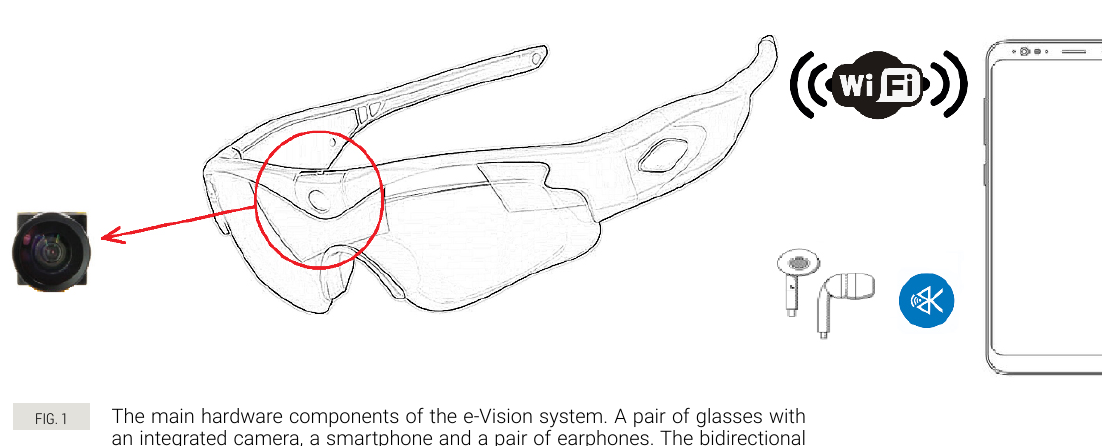
The main hardware components of the e-Vision system. A pair of glasses with an integrated camera, a smartphone and a pair of earphones. The bidirectional communication between the camera and the smartphone is performed through